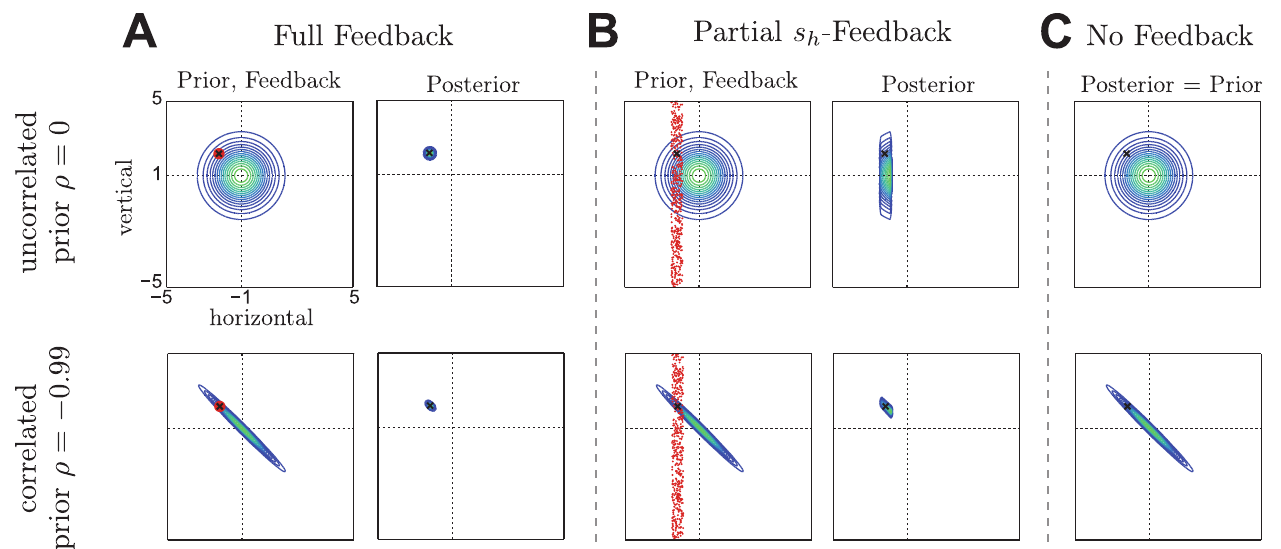
Fig 1. Bayesian integration for two-dimensional Gaussian priors under different feedback conditions A – C . The uncorrelated case is shown in the top row and the correlated case is shown in the bottom row. Prior and posterior are represented through iso-probability contours, the visual feedback is depicted in red and the true shift is marked as a black X. The black dotted lines indicate the prior mean. A Due to the very reliable feedback in the full feedback condition, the posterior is peaked very sharply — regardless of the correlation in the prior. B The partial s h -feedback is reliable in the s h dimension but provides no information about the shift in the s v dimension. This leads to an important difference in the posterior between the correlated and uncorrelated group: knowing the correlation structure reduces uncertainty about the s v dimension of the shift, leading to a more concentrated posterior. C In no-feedback trials, participants can only rely on their prior experience. This feedback condition allows to test for the prior beliefs